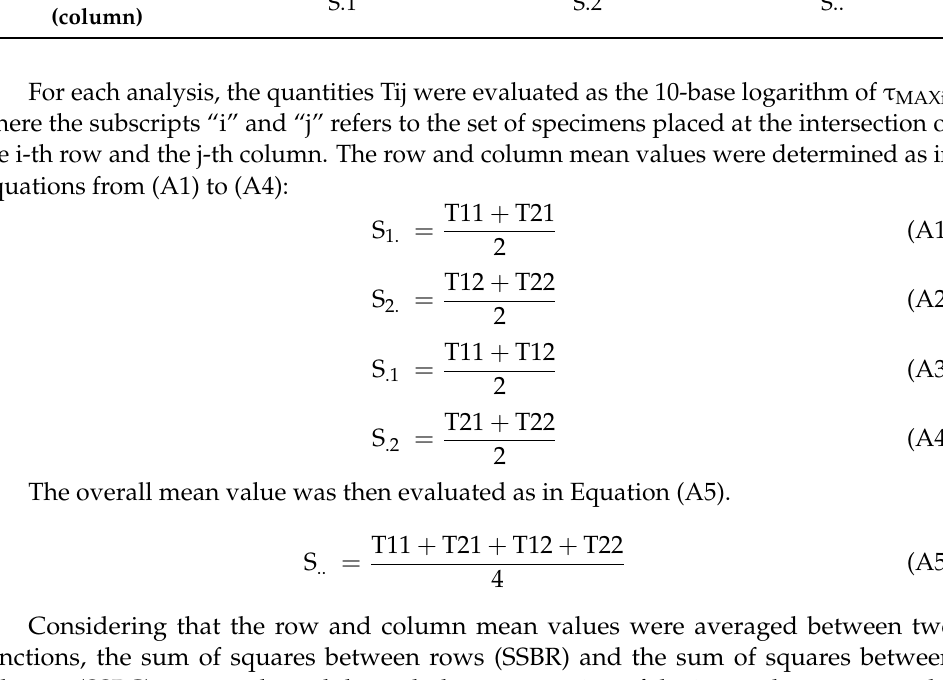
Table A1. Generic design of experiments for ANOVA. Factor B Factor A–Level A1 Factor A–Level A2 Level B1 T11 T21 S1. Level B2 T12 T22 Mean values S.1 S.2 (column)